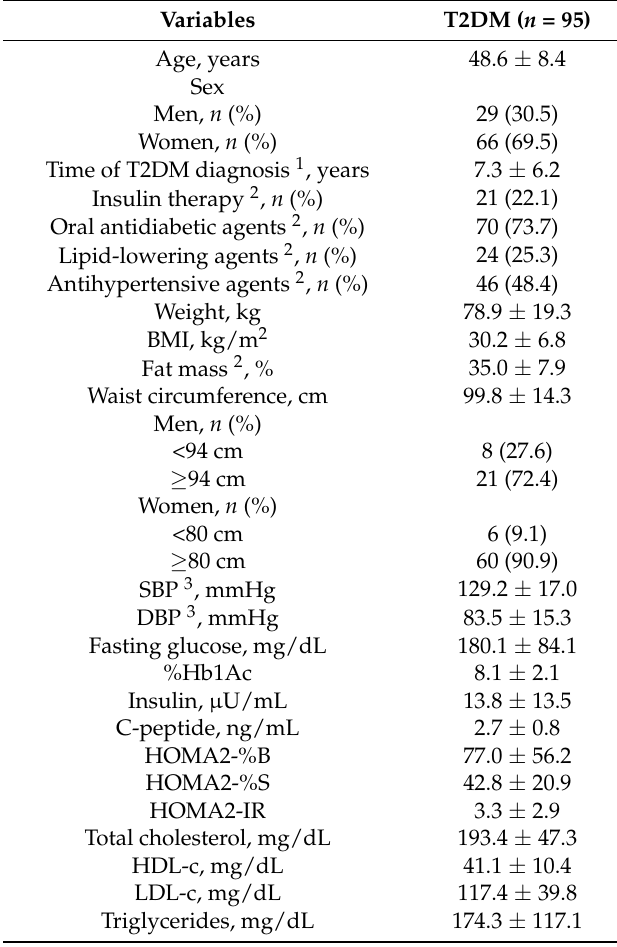
Table 1. Clinical, biochemical and nutrient intake variables of individuals with type 2 diabetes mellitus